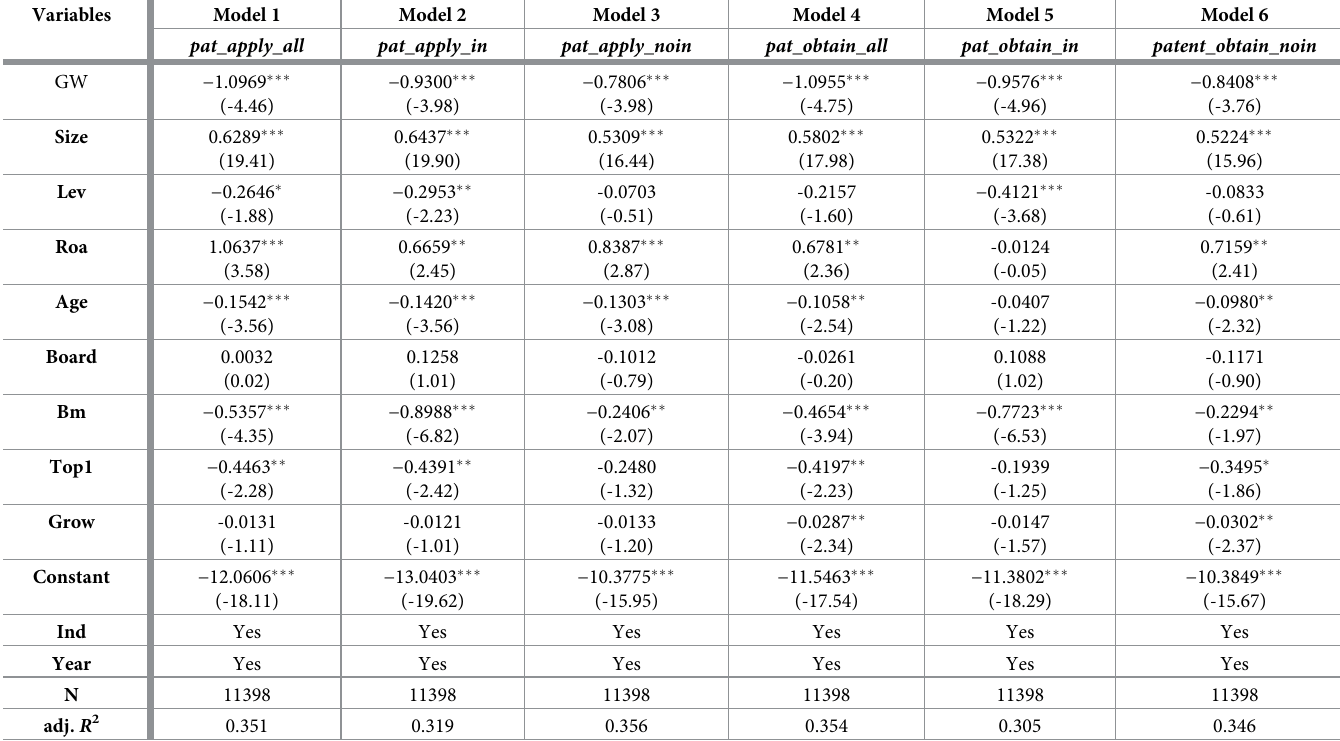
Table 8. Regression results of M&A goodwill and corporate technological innovation